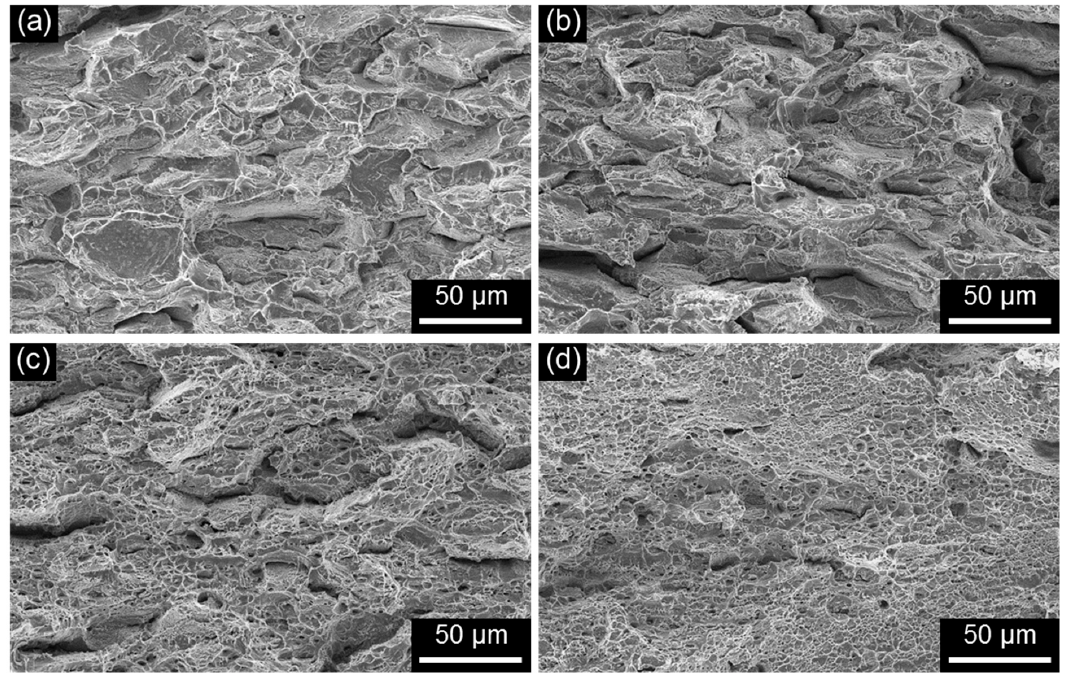
Figure 7. Scanning electron microscope (SEM) fractographs of ( a , b ) D1 and ( c , d ) D2 alloys after the SSRT conducted in air at 25 °C at a strain rate of 10 − 6 s − 1 . The SSRTs were conducted along ( a , c ) L- and ( b , d )